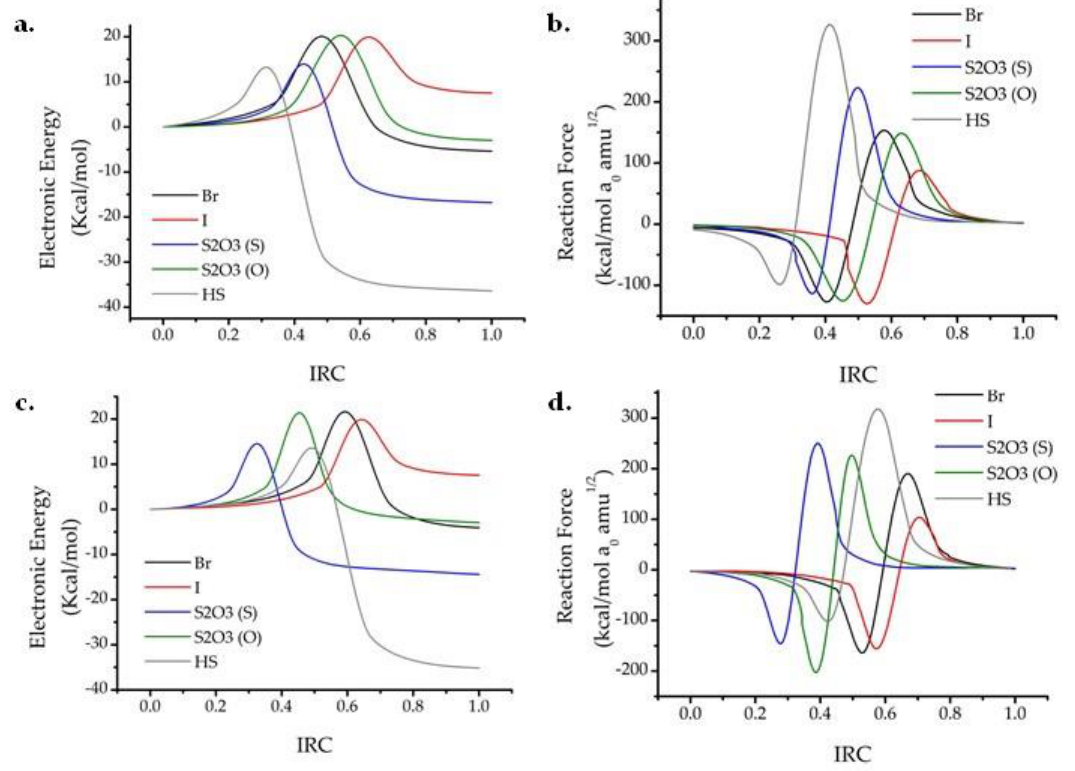
Figure 3. IRC and RF plots for the nucleophilic substitution of alachlor ( a , b ) and propachlor ( c , d ).